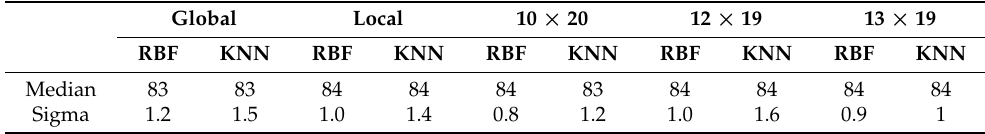
Table 3. F1 score results of the test series with normalized image segments (scaled ROI) for k-nearest neighbors (KNN) and radial basis function (RBF) modes. Global Local